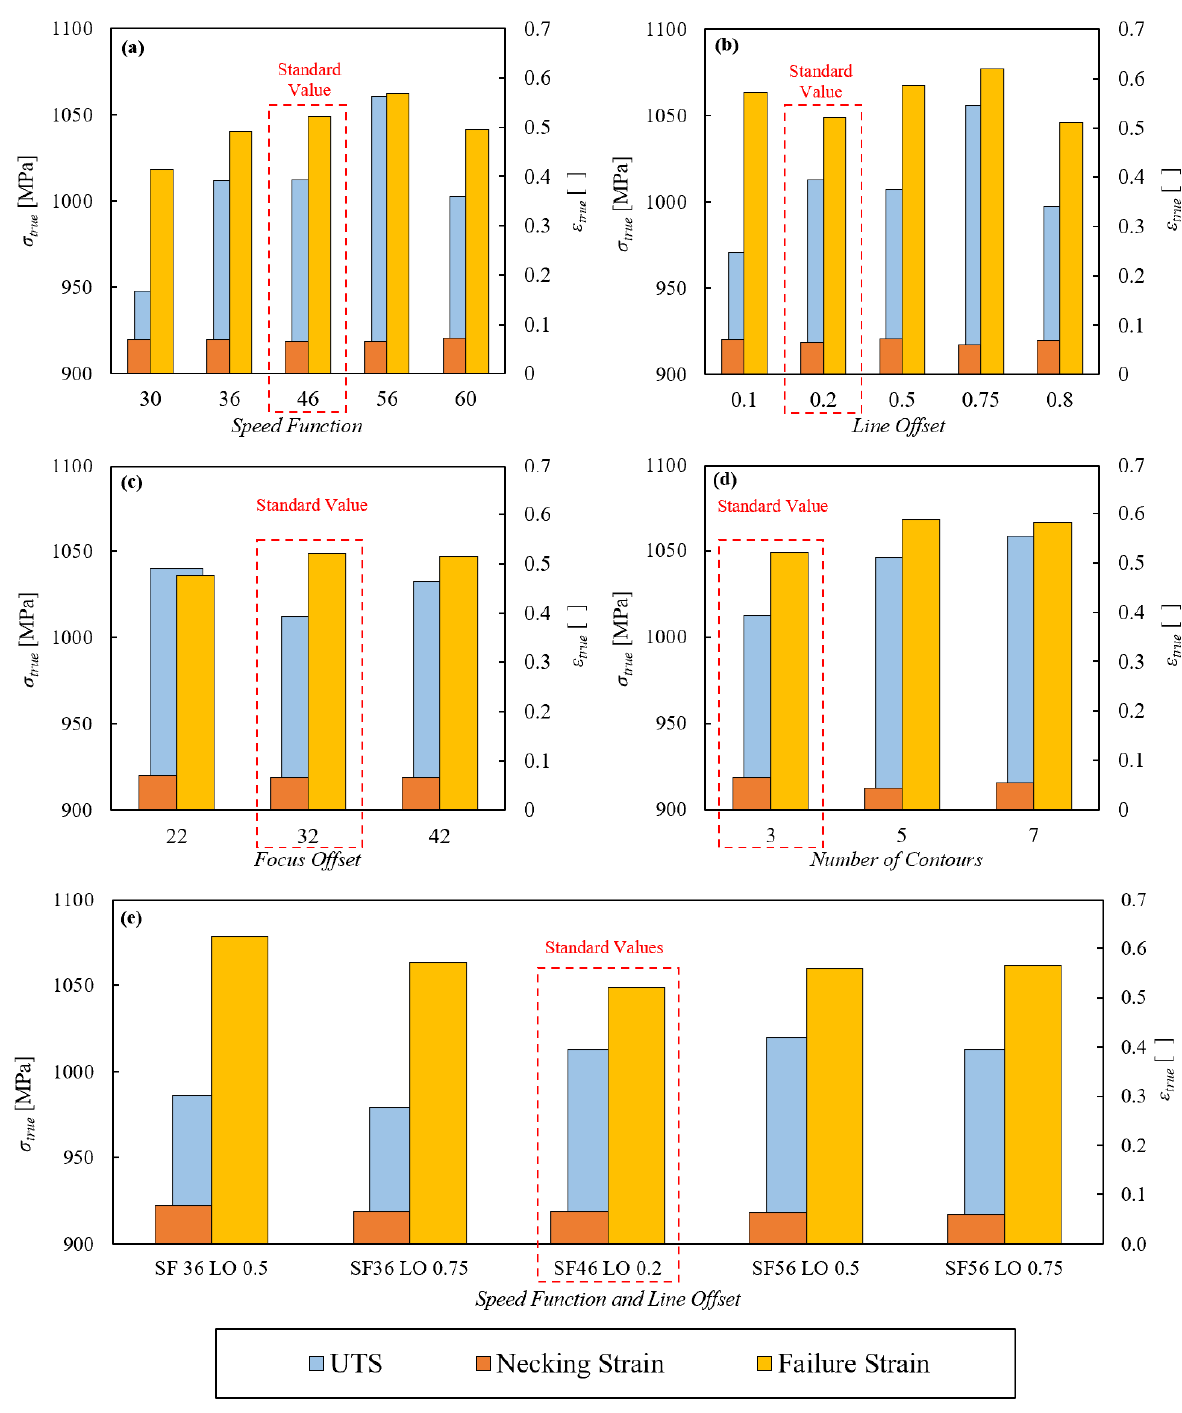
Figure 4. Static experimental series: comparison between the UTS/necking strain/failure strain with the standard EBM parameter set (outlined by the dashed line) and with the variated ones changing the speed function ( a ), line offset ( b ), focus offset ( c ), number of contours ( d ) and speed function and line offset ( e ).